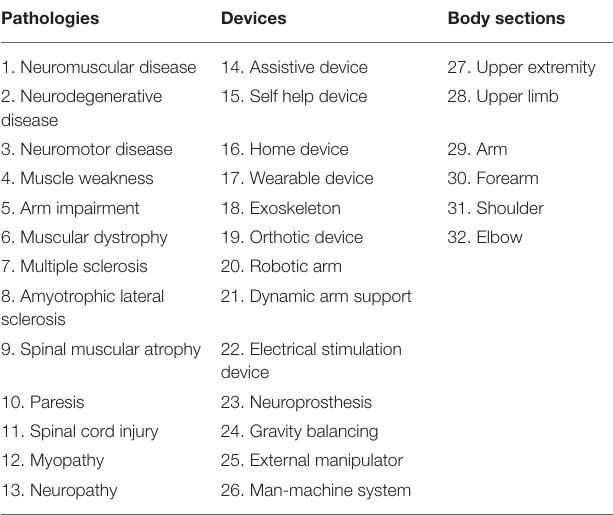
TABLE 1 | Keywords used for searching in electronic database.